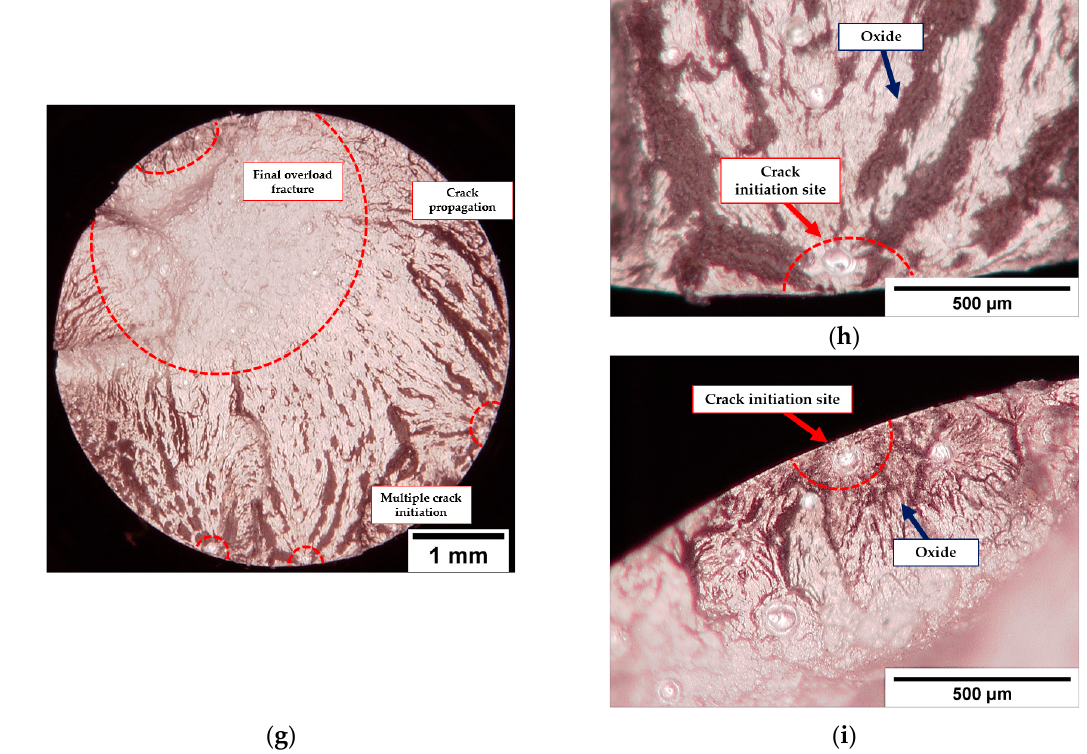
Figure 10. Low magnification multi ‐ focus images for T5 ‐ RT ( a , b ), T5 ‐ 200T ( c , d ), T6R ‐ RT ( e , f ), and T6R ‐ 200T ( g – i ). Fracture surface regions of interest: (i) crack initiation, (ii) crack propagation, and (iii) final overload fracture.